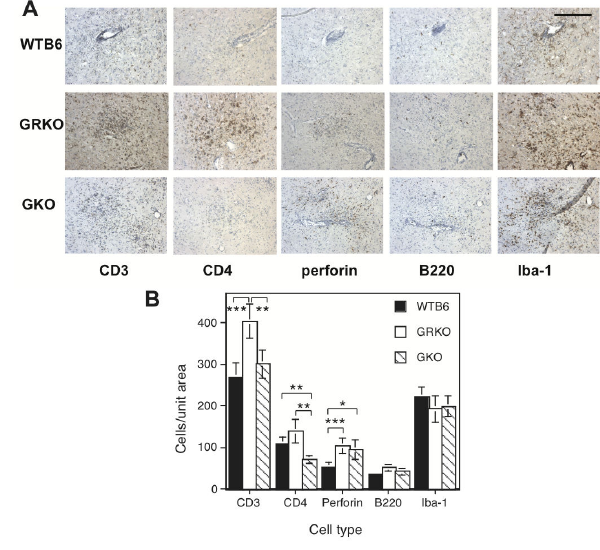
Figure 5. Immunohistochemical staining and quantification of inflammatory cells in the thalamus. Brains from WTB6, GRKO and GKO mice 7 days after intranasal infection with 10 5 pfu NSV were examined for CD3 + , CD4 + , perforin + , B220 + and Iba-1 + cells. Frozen sections of the thalamus from 2 animals per group were immunostained with rabbit polyclonal anti-CD3, rabbit polyclonal anti-CD4, rat monoclonal anti perforin, rat monoclonal anti-B220 and rabbit polyclonal anti Iba-1. (A) Immunohistochemical staining for inflammatory cells. Representative sections are shown. X200. Scale bar = 200 um. (B) Photographs of 13-16 unit areas (0.25 mm 2 )/group were taken (X200 magnification) and numbers of brown stained immune cells were counted. Each bar indicates the mean and SEM. * P < 0.05, ** P < 0.01, *** P < 0.001; t